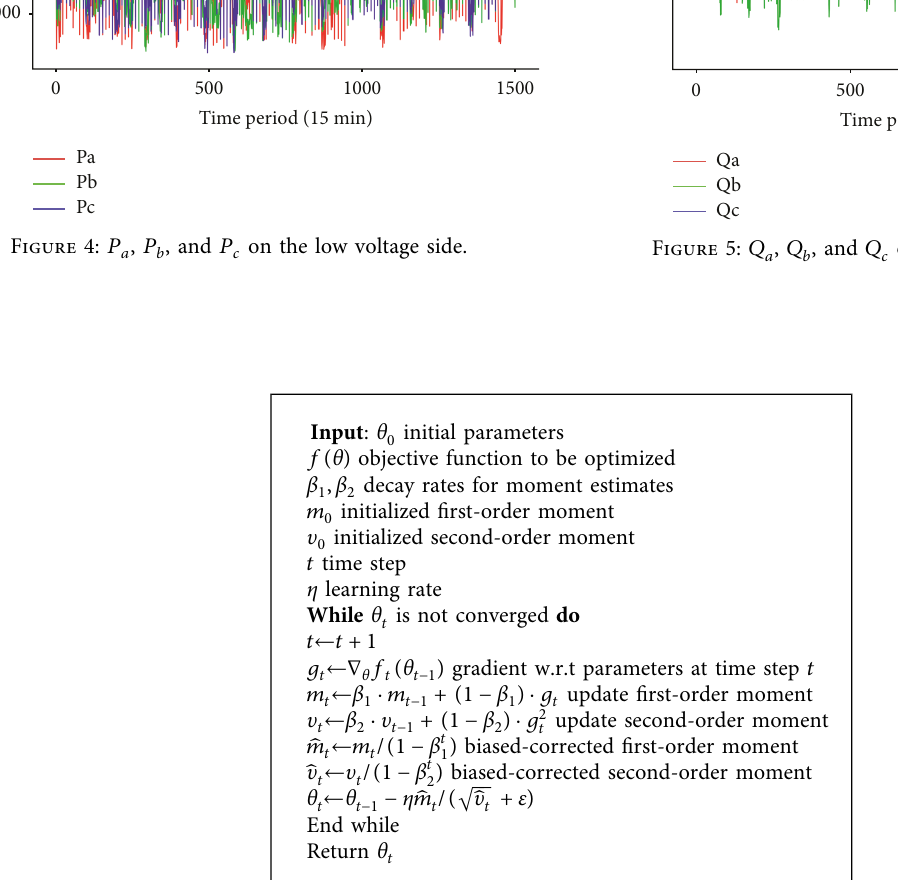
P P a , b , and c on the low voltage side.